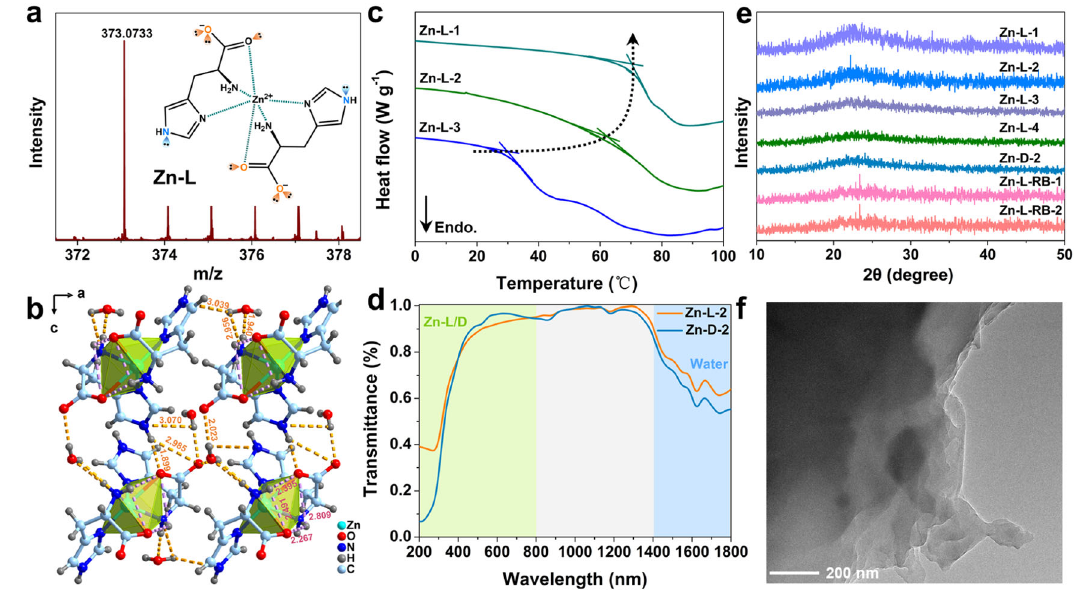
Fig. 2 | The molecular structure of the Zn – L complex, and the thermal prop- erties and morphologies of the SGs. a The HR-ESI-MS spectrum of the Zn – L complex. The inset was the illustration of the molecular structure of the Zn – L complex. b The hydrogen-bonding network in the Zn – L crystal structure. The orange and purple dashed lines respectively represent intra/intermolecular hydrogen bonds. There were intra/intermolecular hydrogen bonds between the complexes, as well as hydrogen bonds between the complexes and the solvent water molecules. The Zn – L complex showed a twist con fi guration in the crystal,